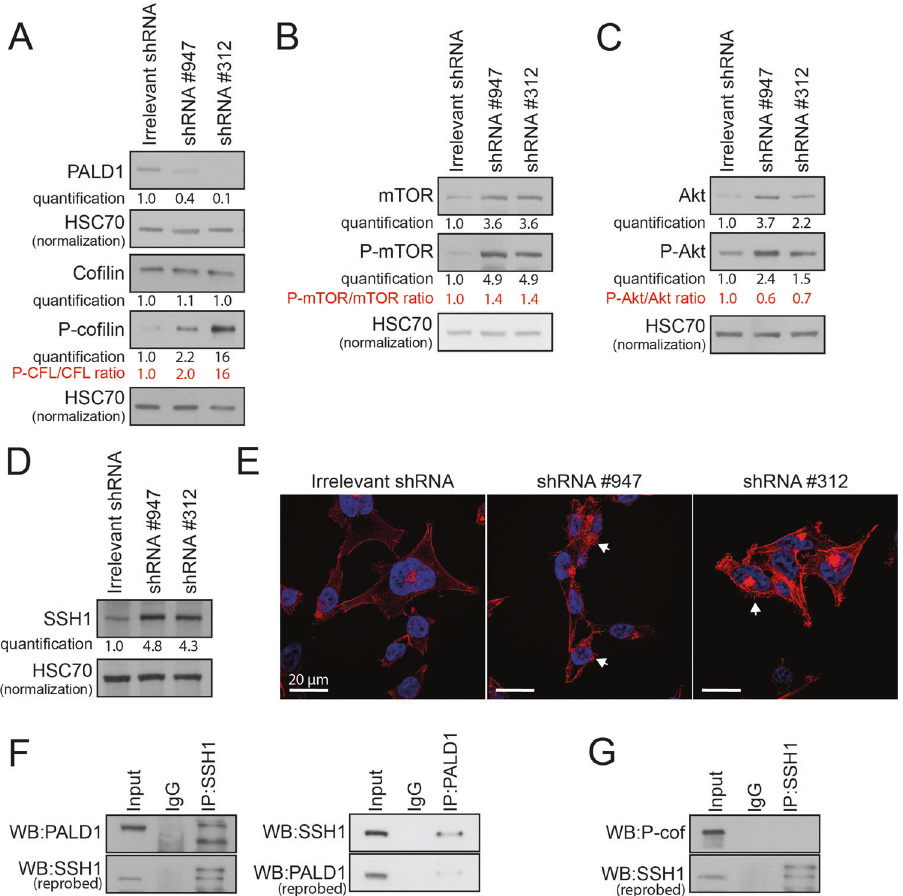
Fig. 5 Paladin interacts with slingshot homologue-1 and regulates the phosphorylation level of actin remodelling regulators in HCT116. A Paladin and serine 3 phospho-co fi lin western blot in HCT116 shRNA clones. B mTOR and serine 2481 phospho-mTOR western blot in HCT116 shRNA clones. C Akt and serine 473 phospho-AKT western blot in HCT116 shRNA clones. D SSH1 western blot in HCT116 shRNA clones. HSC70 was used as a loading control. E Actin staining with fl uorescent phalloidin in HCT116 shRNA clones. White arrows show fi lopodia. F , G HCT116 lysates were immunoprecipitated with SSH1, paladin or irrelevant antibodies (IP) followed by western blot with paladin, SSH1 or phospho-co fi lin antibodies